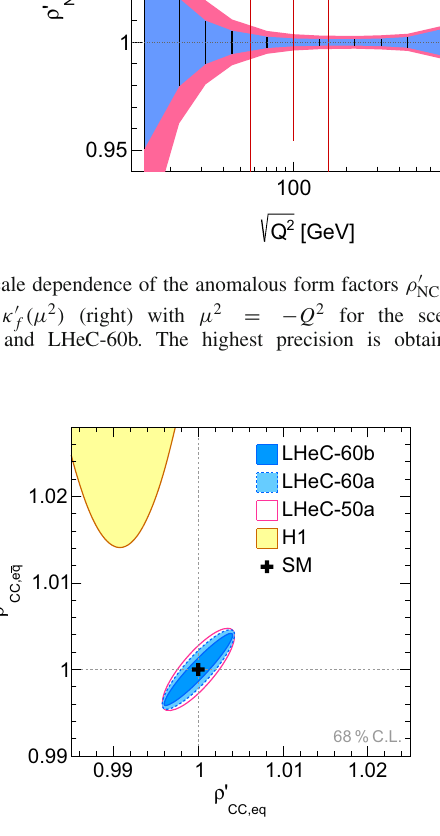
Fig. 14 Expected uncertainties of anomalous CC coupling parameters ρ (cid:9) and ρ (cid:9) for three different LHeC scenarios compared with CC , eq CC , e ¯ q results from the H1 measurement